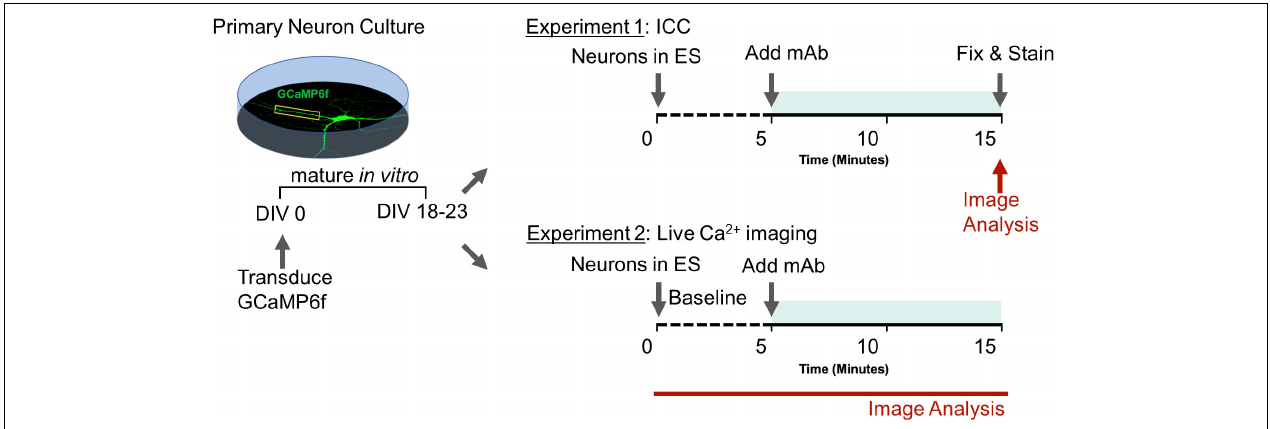
FIGURE 1 | Experimental design to assess role of human GluN1 monoclonal antibodies on synaptic function. Teal shaded bar represents mAb incubation period. Red indicates imaging sessions. DIV, days in vitro ; ES, extracellular solution; ICC, immunocytochemistry; mAb, human monoclonal antibodies.